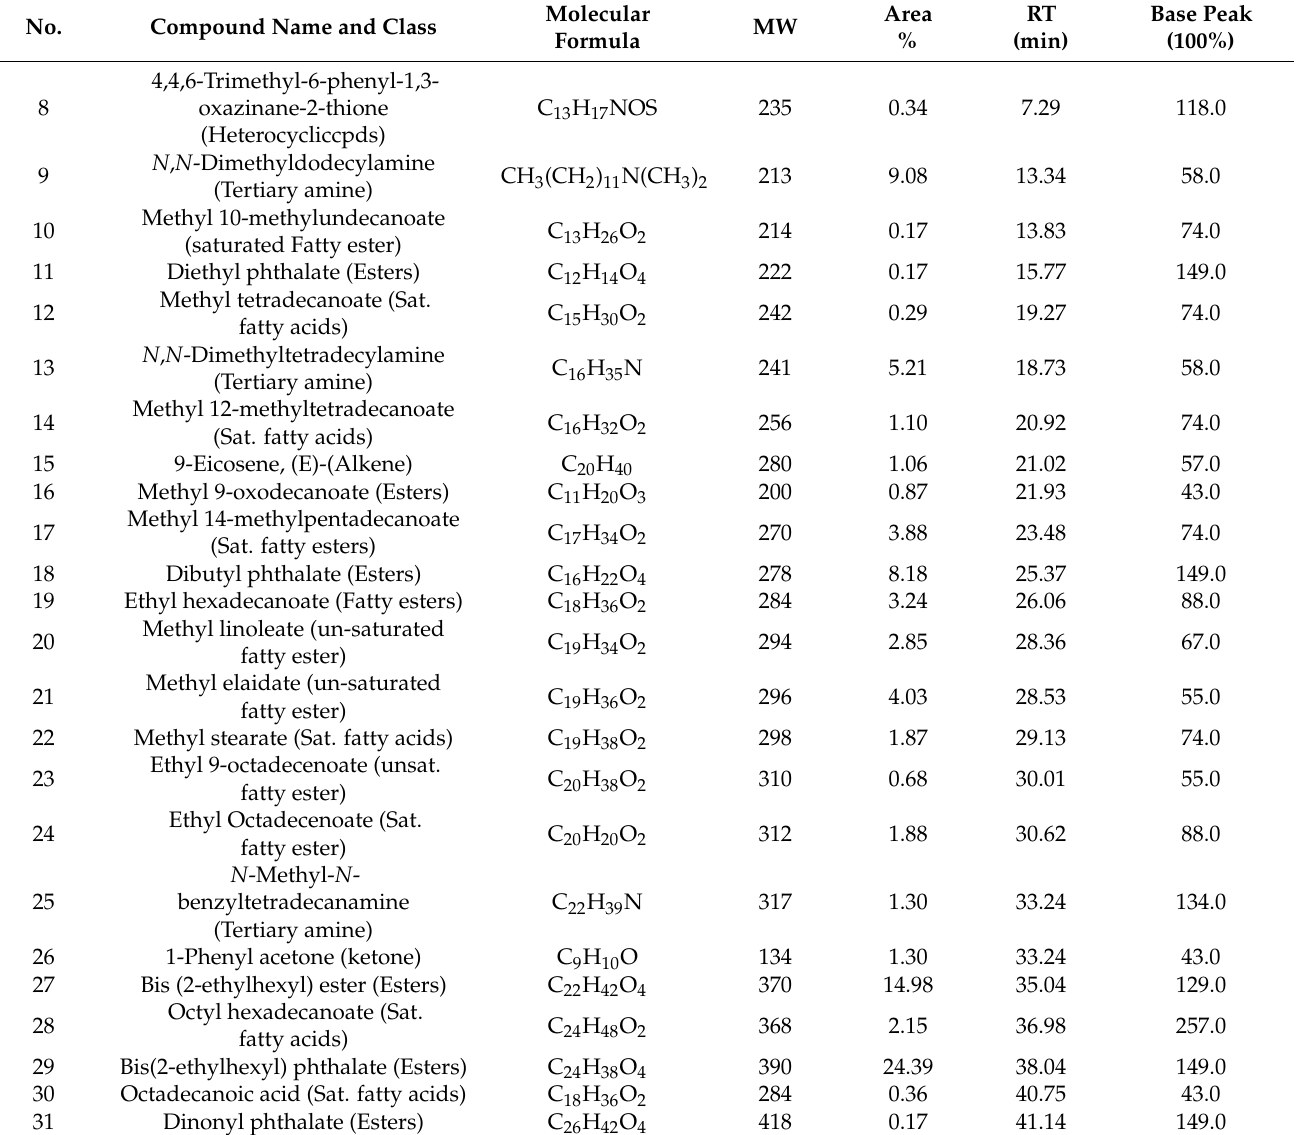
Table 5. List of identified bioactive compounds of endophytic B. velezensis extract by GC-MS analysis.